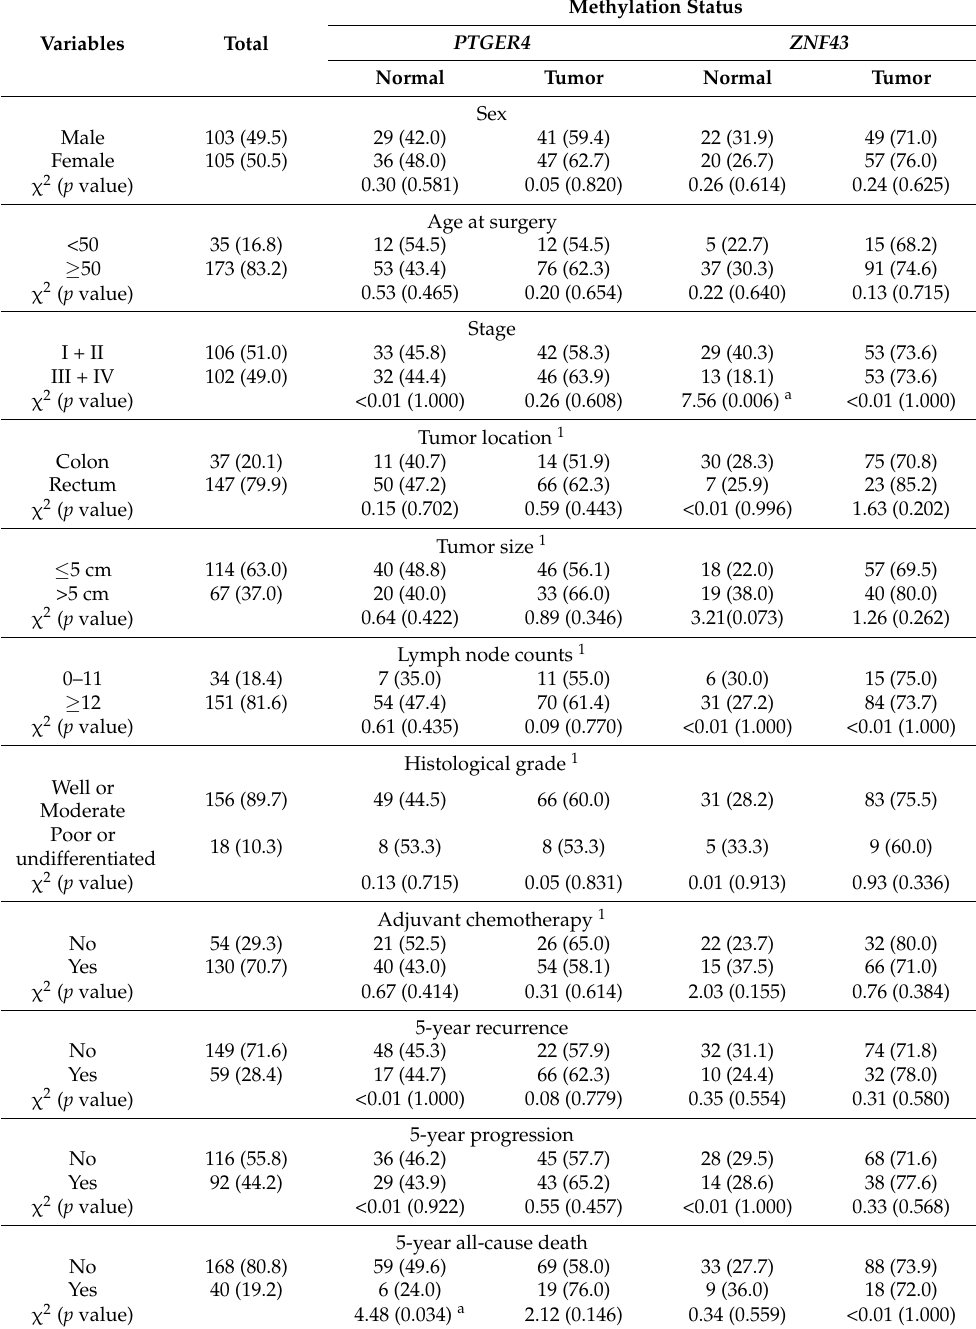
Table 1. CRC patients’ characteristics and methylation status distribution (n =